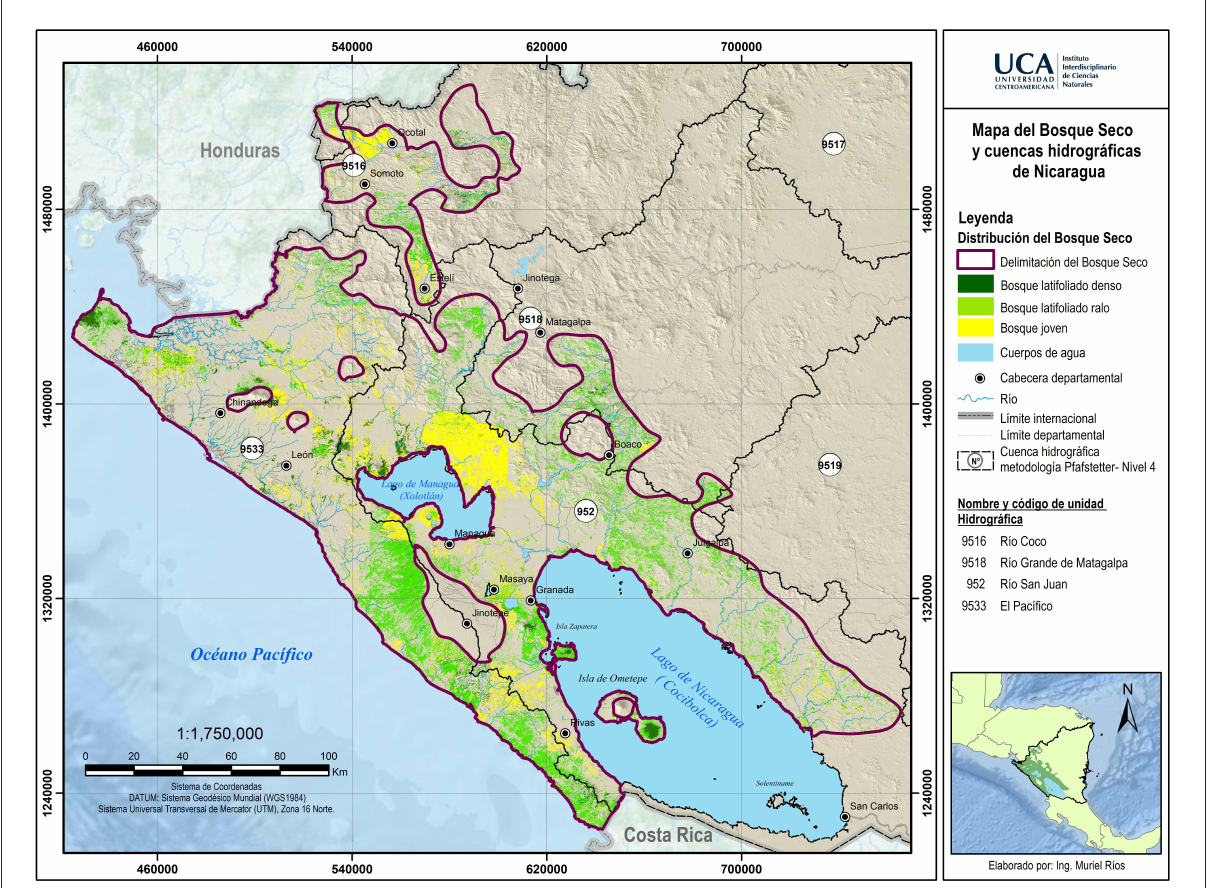
FIGURE4 Map of dry tropical forests in Pacific of Nicaragua, elaborated by Ing. Muriel